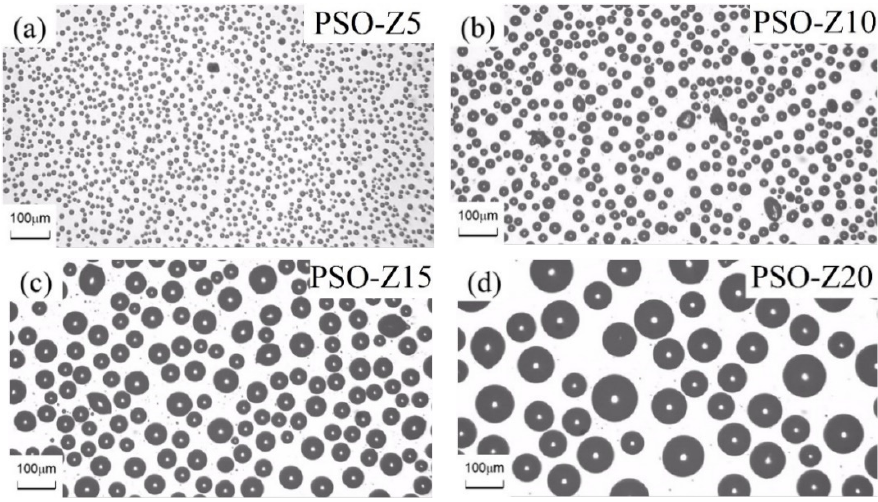
Figure 9. OM morphology of leached PSO droplets on PSO/PDMS coatings: ( a ) PSO-Z5, ( b ) PSO-Z10, ( c ) PSO-Z15, ( d ) PSO-Z20.